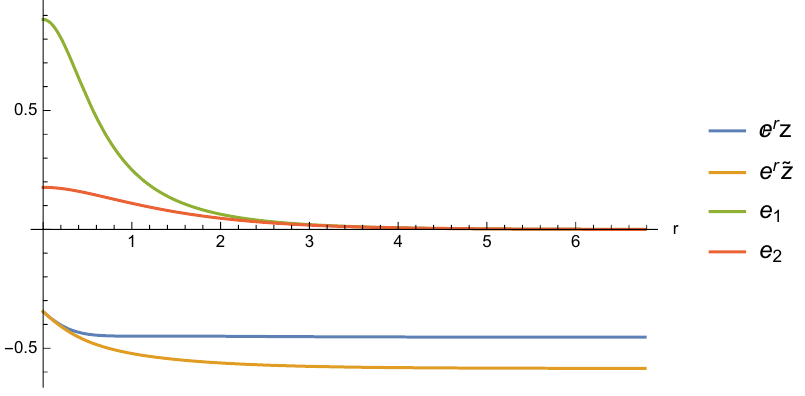
Figure 7 . Numerical solutions of e r z ( r ) , e r ˜ z ( r ) , e 1 ( r ) − e 1 ( r end ) and e 2 ( r ) − e 2 ( r end ) as a function of r for Case 1 with q R = 5 2